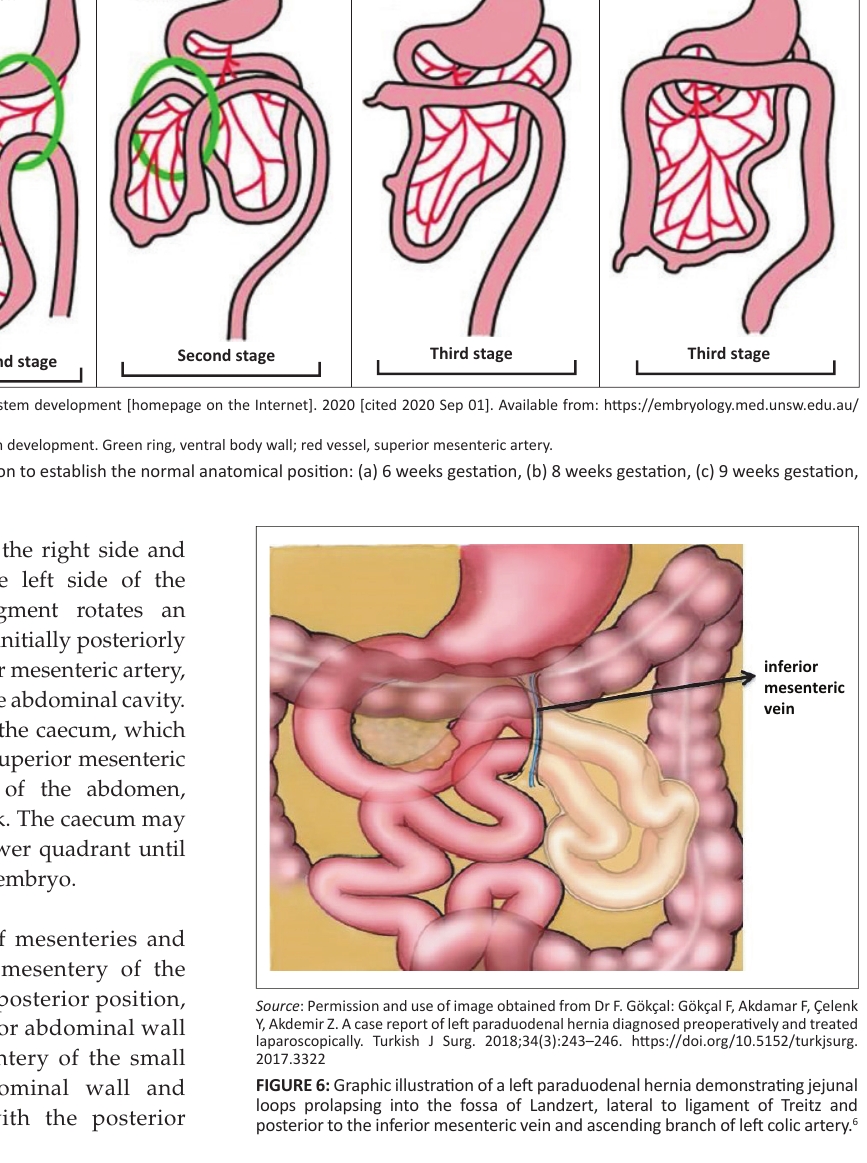
FIGURE 6 : Graphic illustration of a left paraduodenal hernia demonstrating jejunal loops prolapsing into the fossa of Landzert, lateral to ligament of Treitz and posterior to the inferior mesenteric vein and ascending branch of left colic artery.